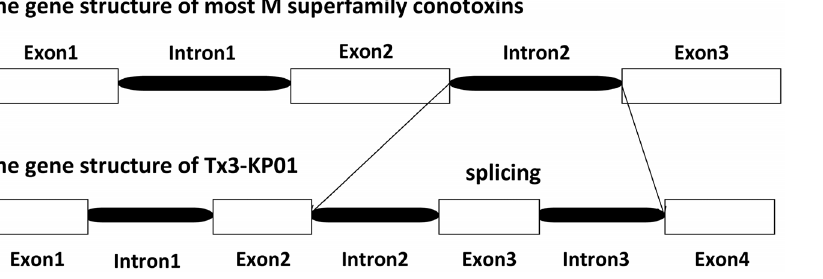
Figure 2. Alternative splicing of the M superfamily conotoxin Tx3-KP01. Intron2 was divided into two new introns and a new exon.